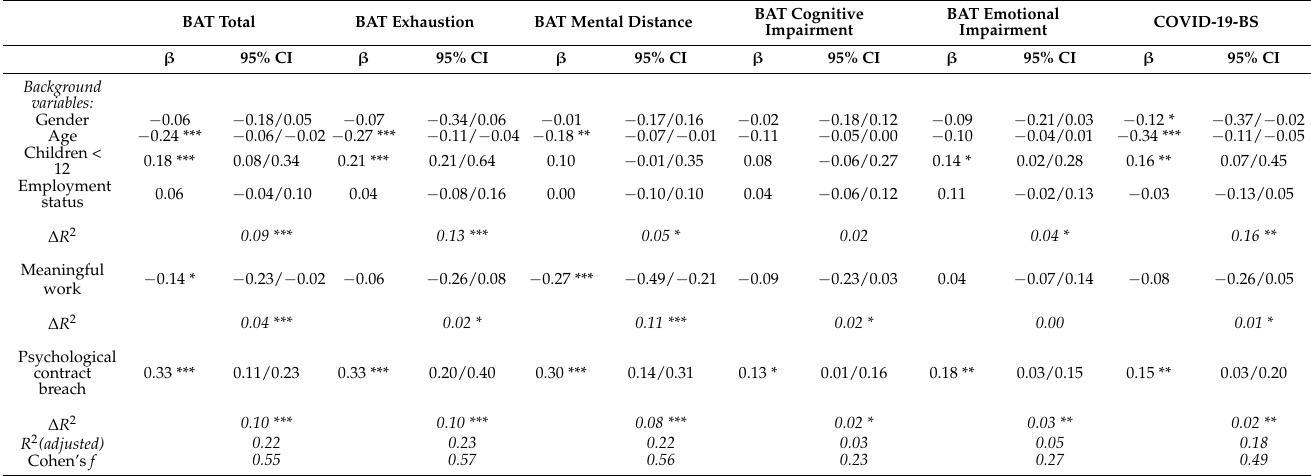
Table 4. Linear regression analyses for the psychological factors on the different burnout measures (BAT and